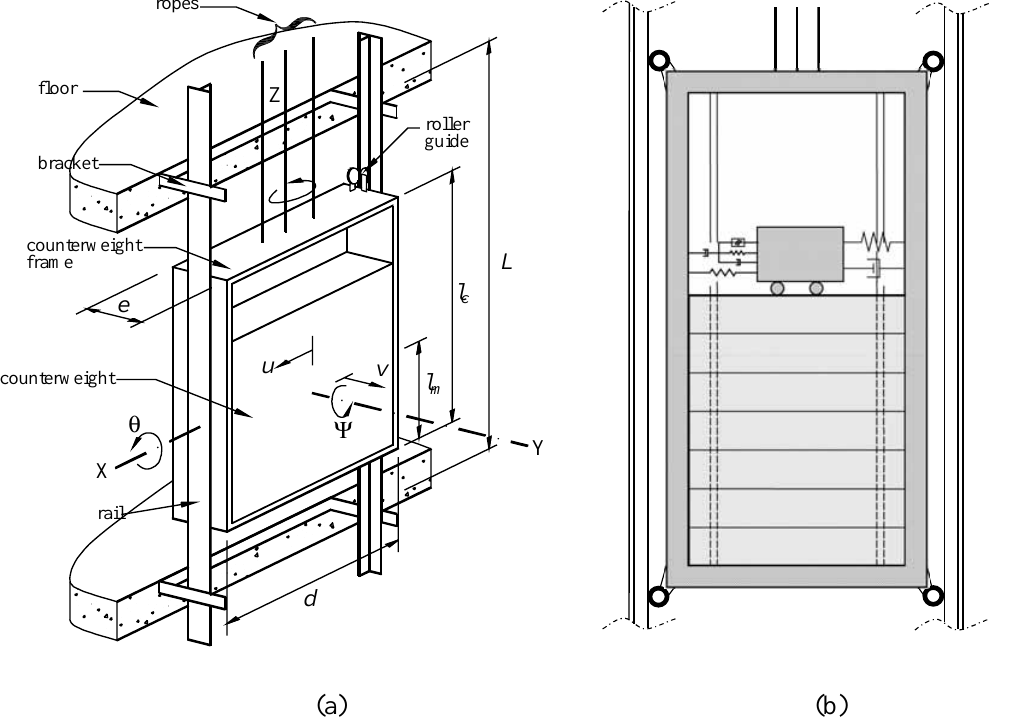
Fig. 1. (a) The sketch showing a counterweight and rails and five dynamic degrees-of-freedom, and (b) the proposed configuration of an in-plane tuned mass damper in the counterweight